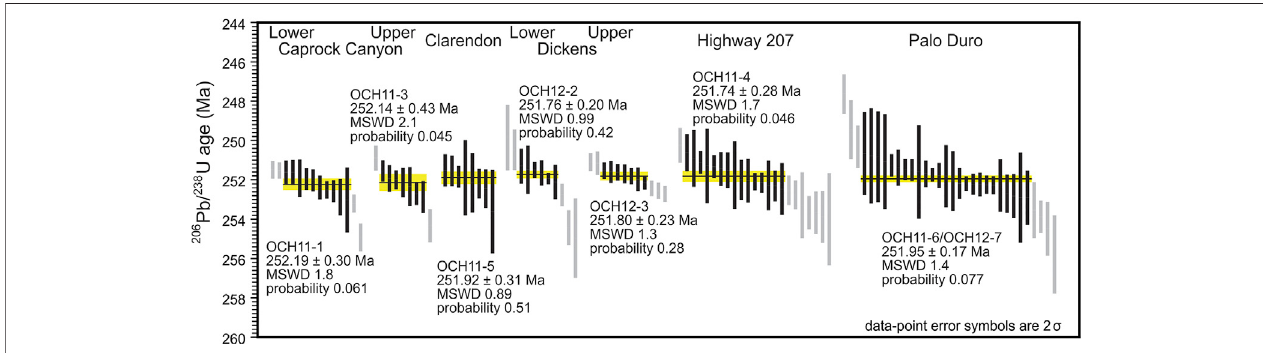
FIGURE 6 | Age ranked 206 Pb/ 238 U ages of U-Pb single zircon CA-TIMS analyses of seven samples from fi ve sections. Black bars show the largest youngest subset with an acceptable probability of fi t ( see text), grey bars are omitted from the calculation of the mean (interpreted as Pb loss and crystals predating the eruption/ deposition age). Yellow horizontal bars depict the weighted mean age for each sample (errors are given at the 95% con fi dence